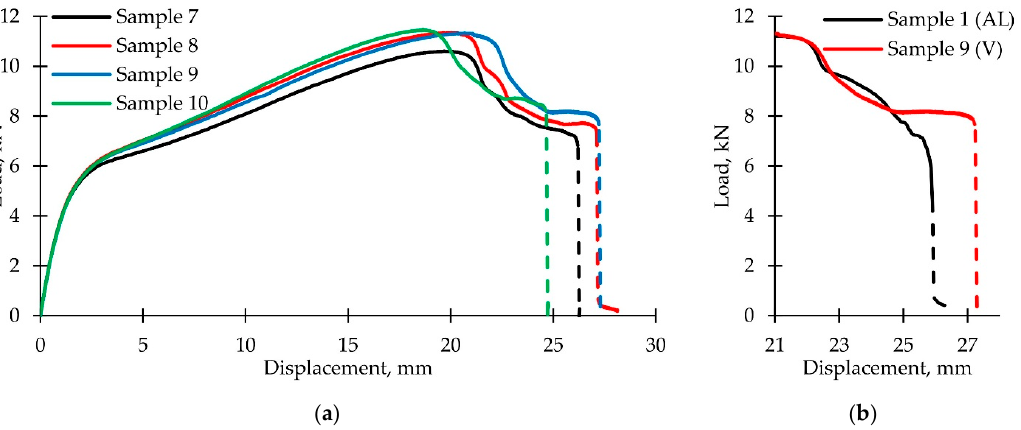
Figure 11. Loading diagrams with additional torsion vibrations: ( a ) Experimental data; ( b ) comparison between postcritical stage during active loading and loading with additional vibrations.